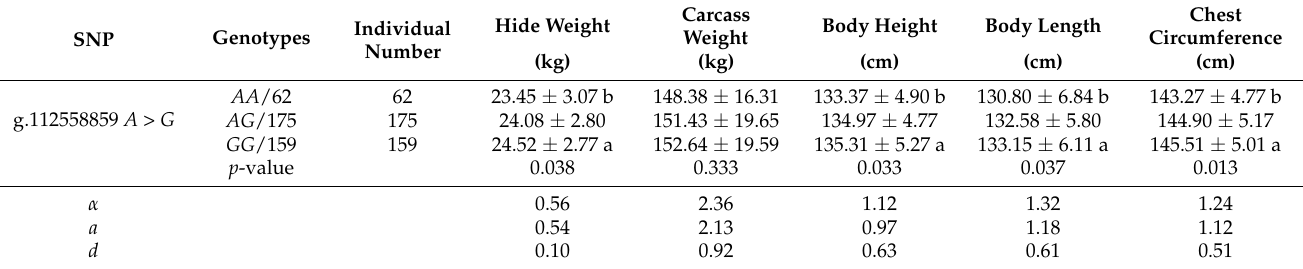
Table 3. Association between the g.112558859 A > G locus within the LCORL gene and growth traits and hide weight of the Dezhou donkey.